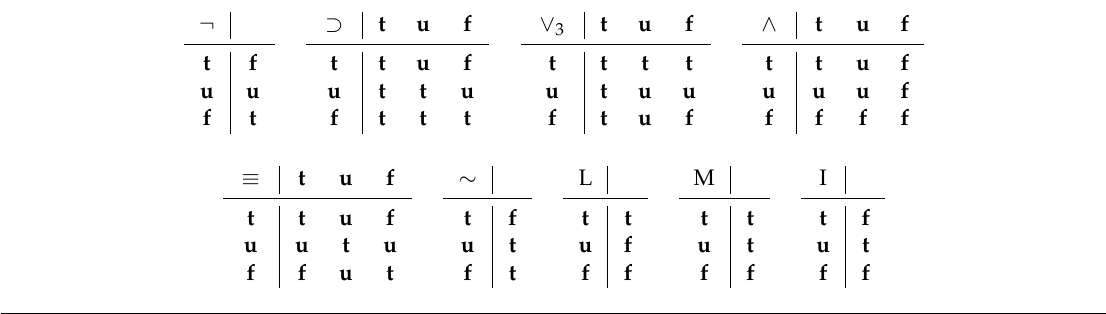
Figure 1. Truth tables for the connectives of Ł 3